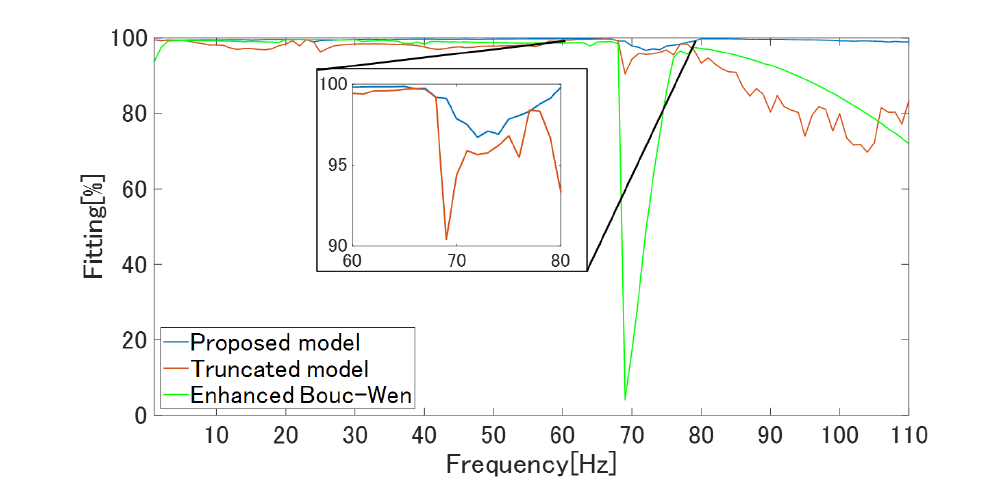
Figure 14. Fitting rates of the three models tested.